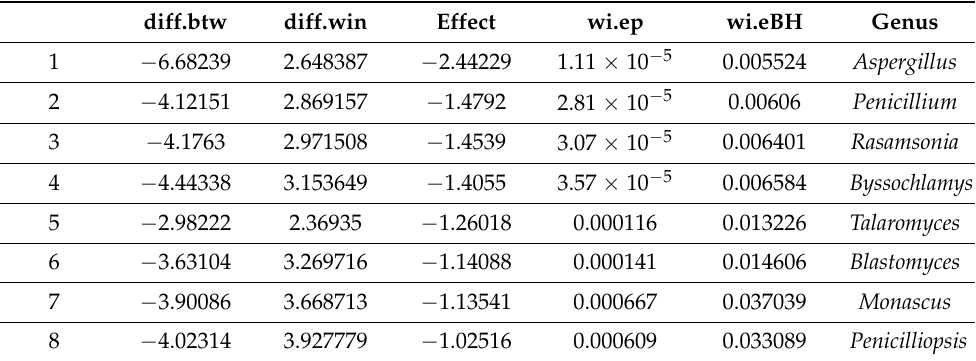
(Table 1). All the fungal genera detected belong to the Ascomycota phylum, Pezizomycotina subphylum, Leotiomyceta clade, Eurotiomycetes class, and Eurotiomycetidae subclass. At the order level, we found genera belonging to the Eurotiales and Onygenales. The most abundant families were Aspergillaceae and Trichocomaceae followed by Thermoascaceae and Ajellomycetaceae. Table 1. ANOVA-like differential expression (ALDEx2). Fungal genera differentially abundant in ancient and extant cultures. diff.btw diff.win Effect wi.ep wi.eBH